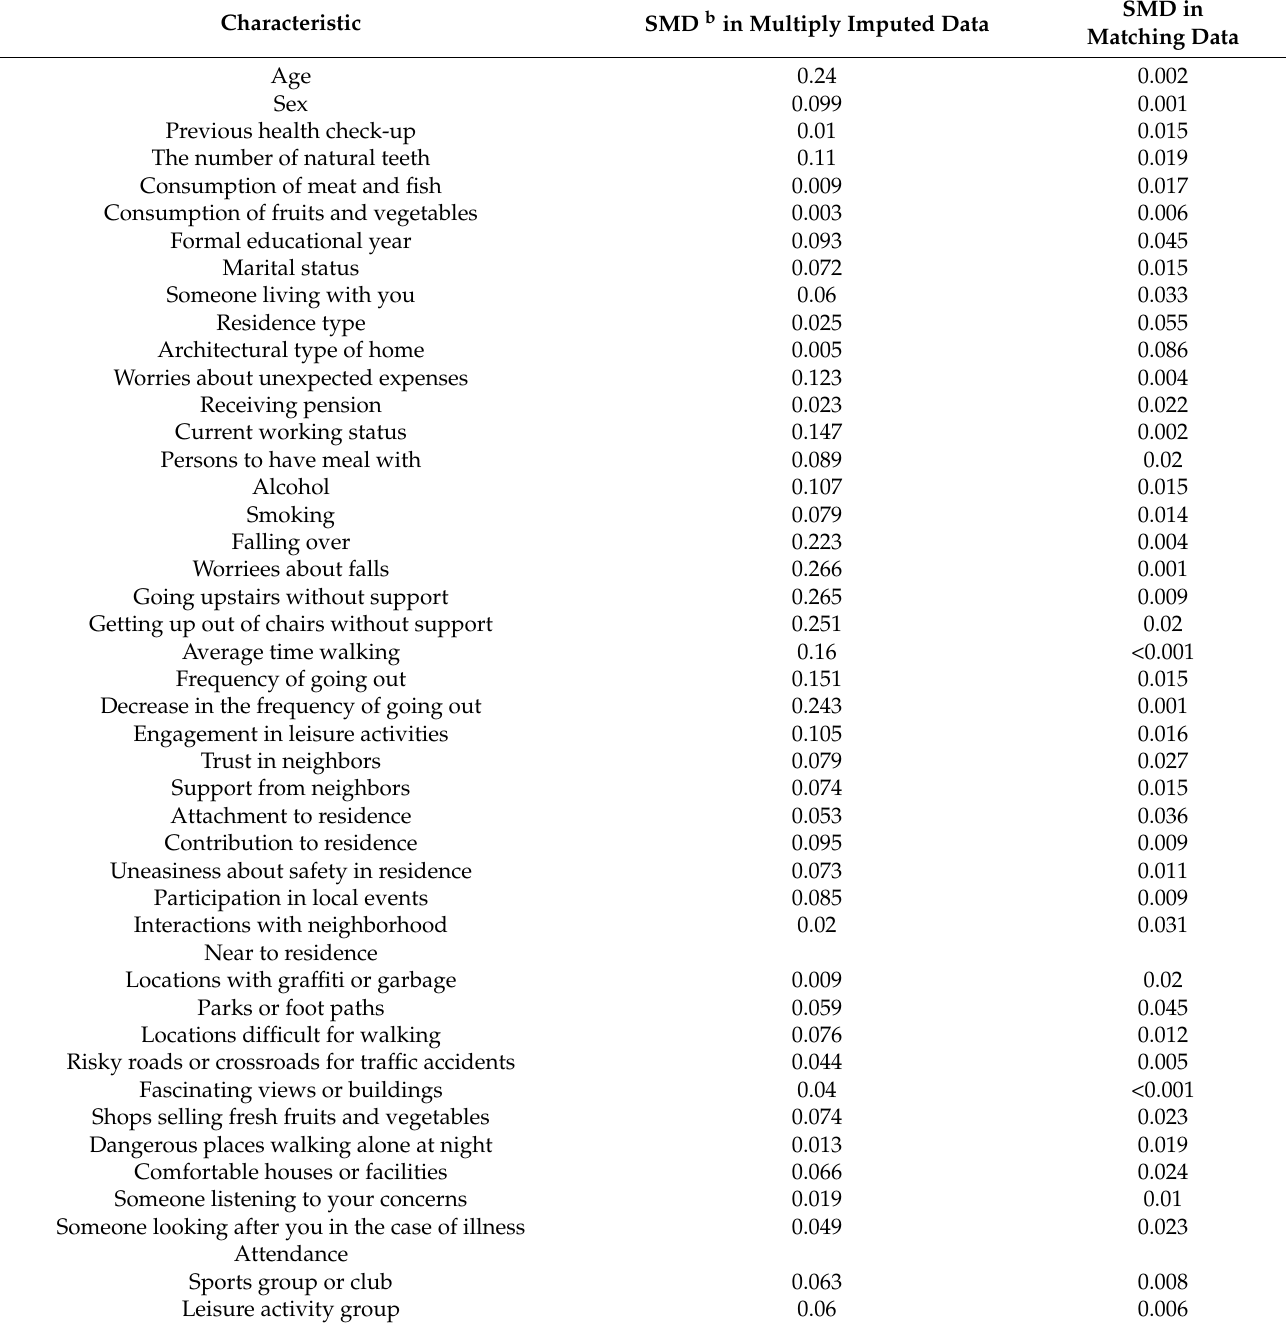
Table 2. Standardized mean differences with or without MM a , before and after Propensity Score